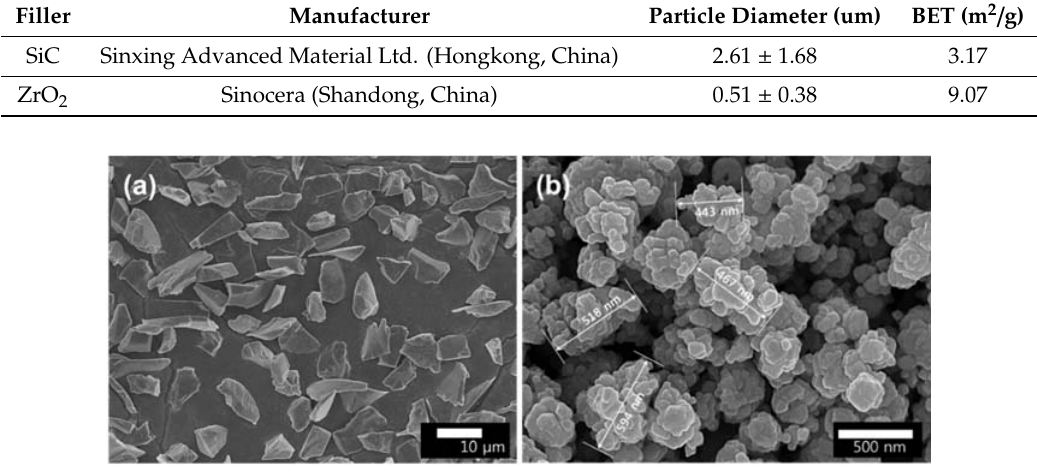
Figure 1. FESEM images of ( a ) SiC and ( b ) ZrO 2 particles.